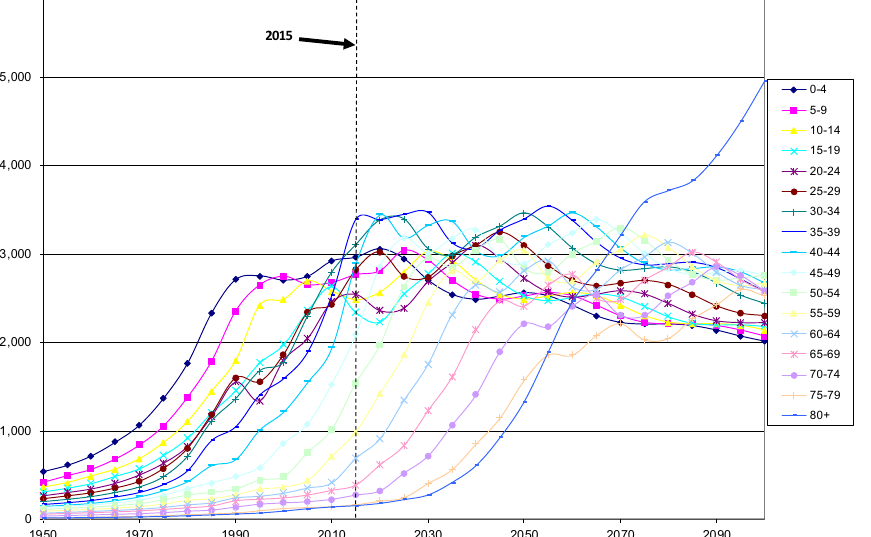
Figure 1. The 17 age groups constituting the Saudi pyramid of ages for the 1950-2100